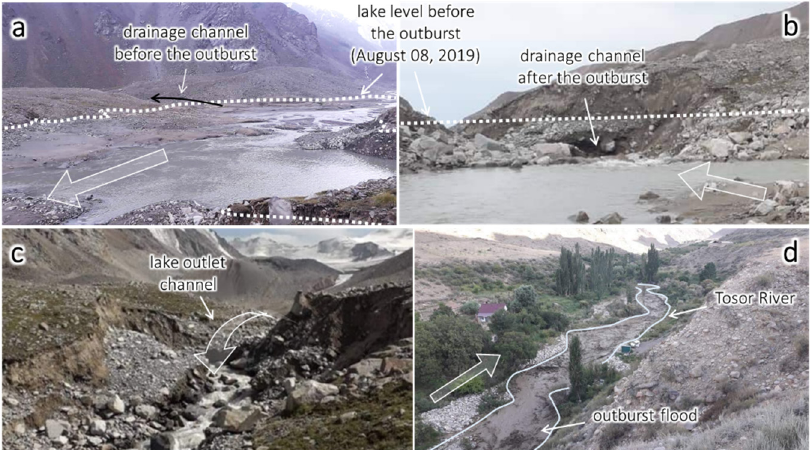
Figure 4. The Toguz-Bulak glacial lake outburst flood. All photos taken on 9 August 2019. ( a ) Lake condition after the outburst. ( b ) Drainage channel through the dam. ( c ) Lake outlet from below and eroded stream banks. ( d ) Flooded area along the Tosor River. Large white arrows show the flow direction.